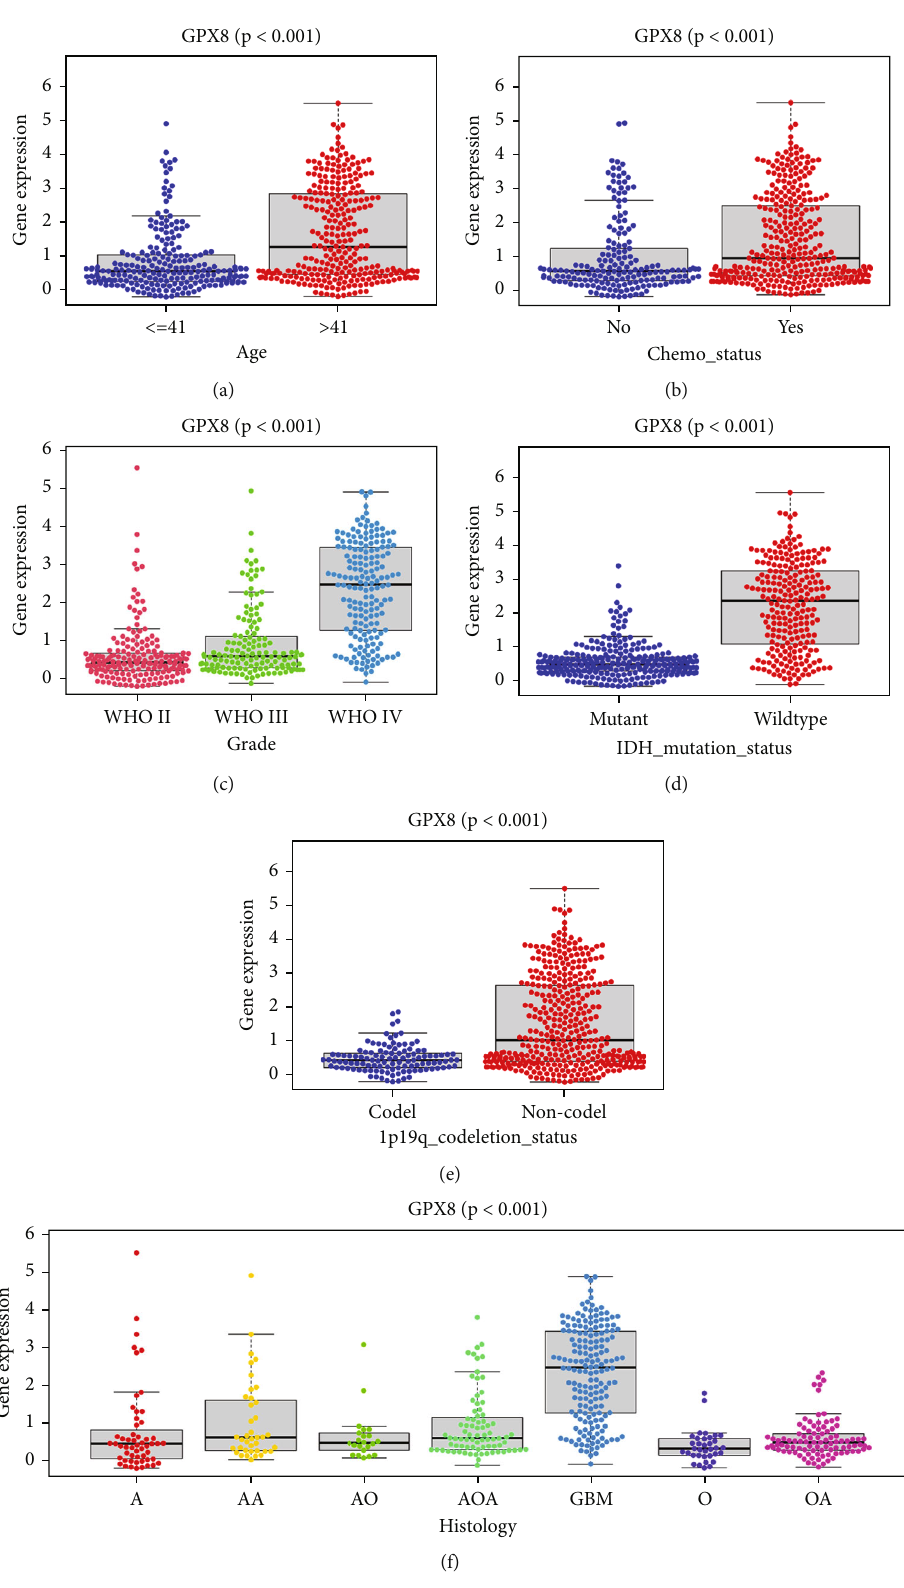
Figure 4: Relationship between GPX8 gene expression and clinical features of primary gliomas ( n = 502